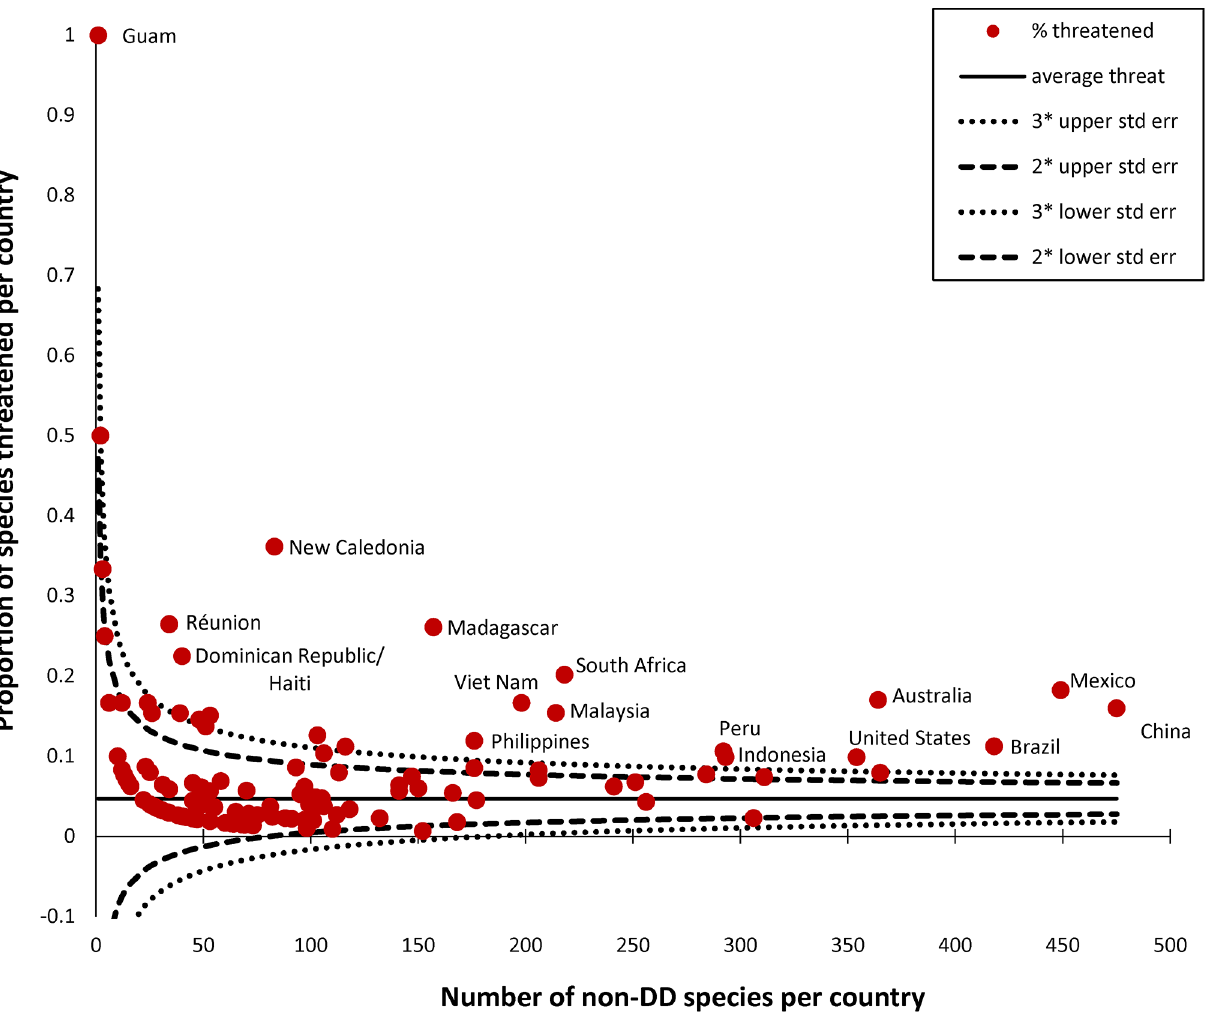
Fig 5. Funnel plot of degree of threat as a proportion of species assessed per country for the combined SRLI for Plants sample of gymnosperms, monocots, legumes and